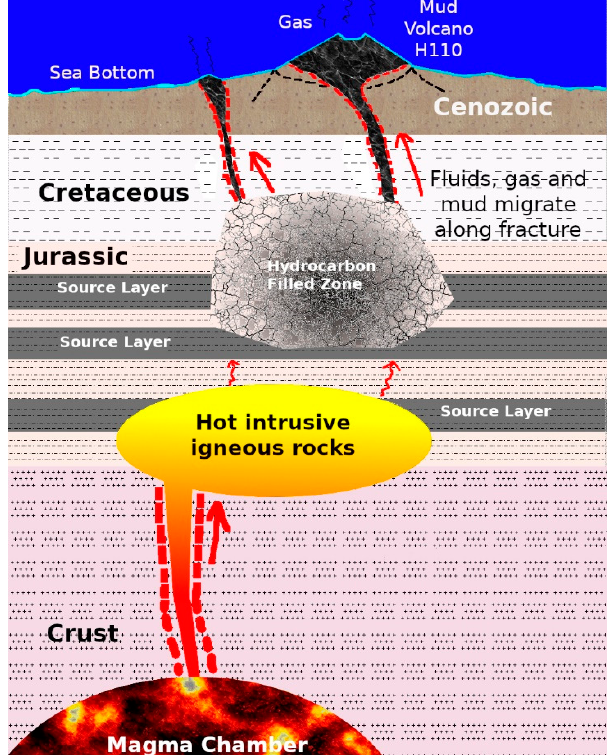
Figure 13. A schematic mud volcanism, driven by magma intrusion at the hill H110.